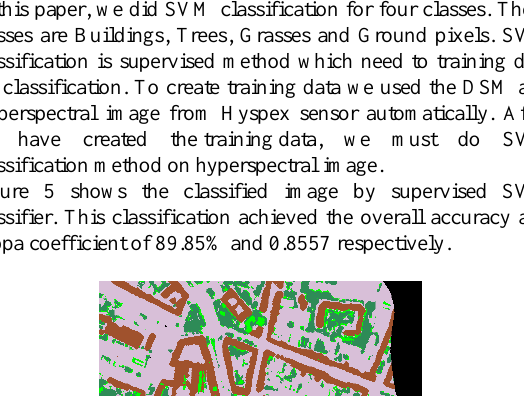
Figure 4. Testing Data for evaluation